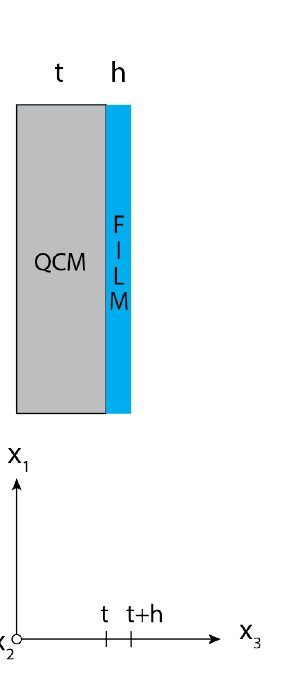
Figure 13. Model of viscous